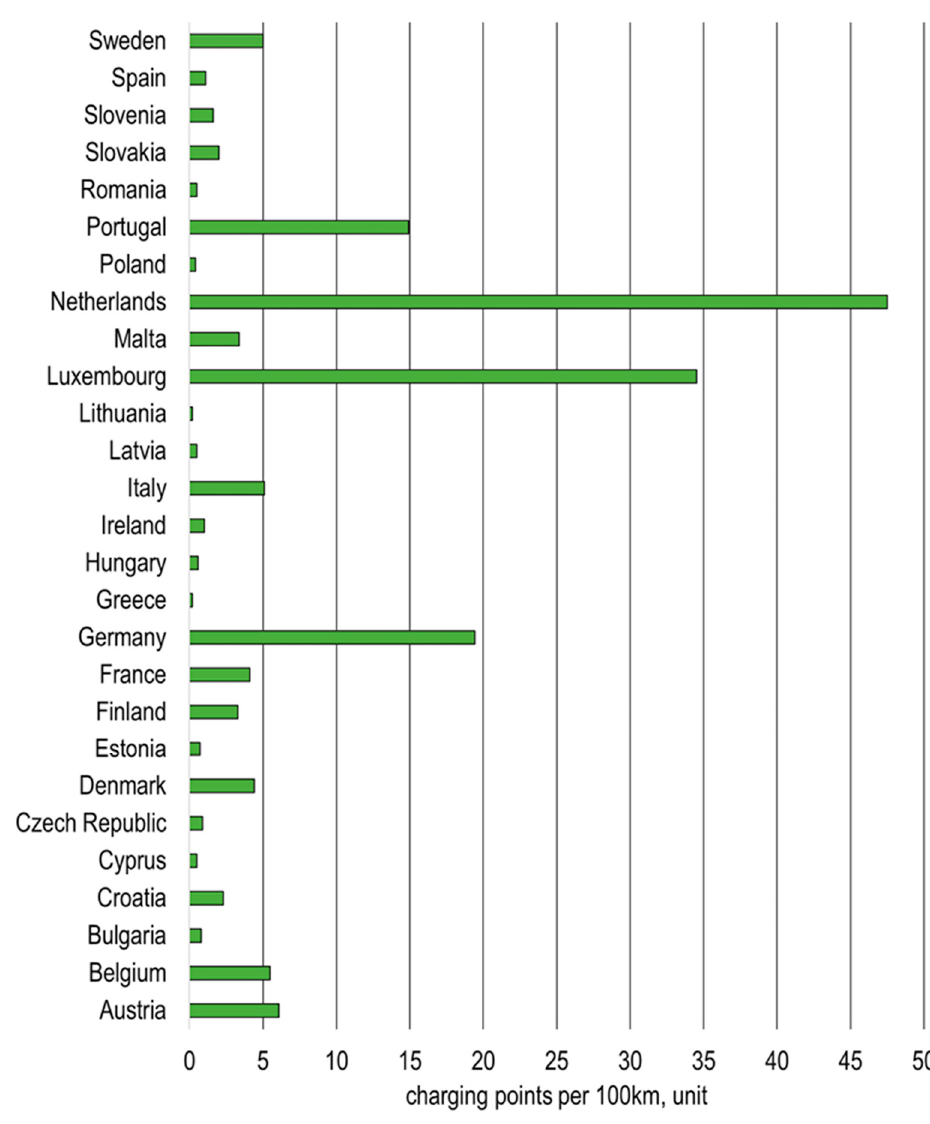
Figure 5. Number of charging points for every 100 km of 100 km roads in EU, by country.